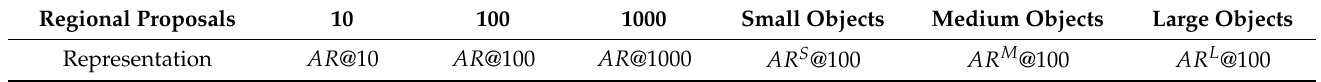
Table 3. Denotations of the average recalls for different situations.